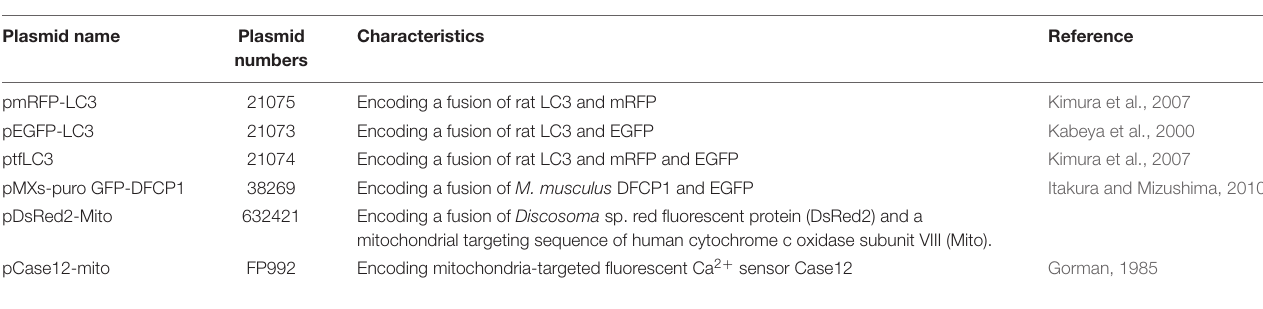
TABLE 1 | Information of